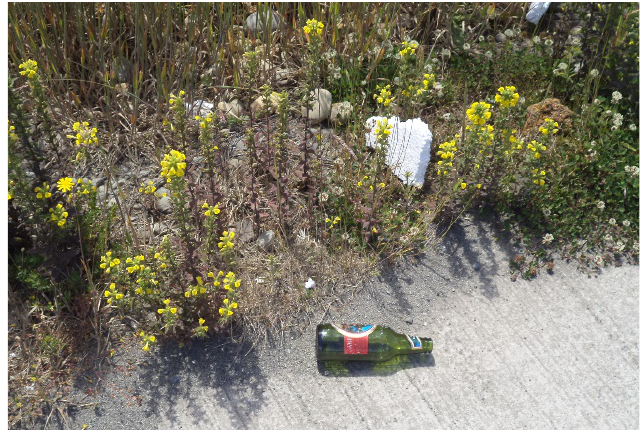
Figure 4: Trash found in the roadside study